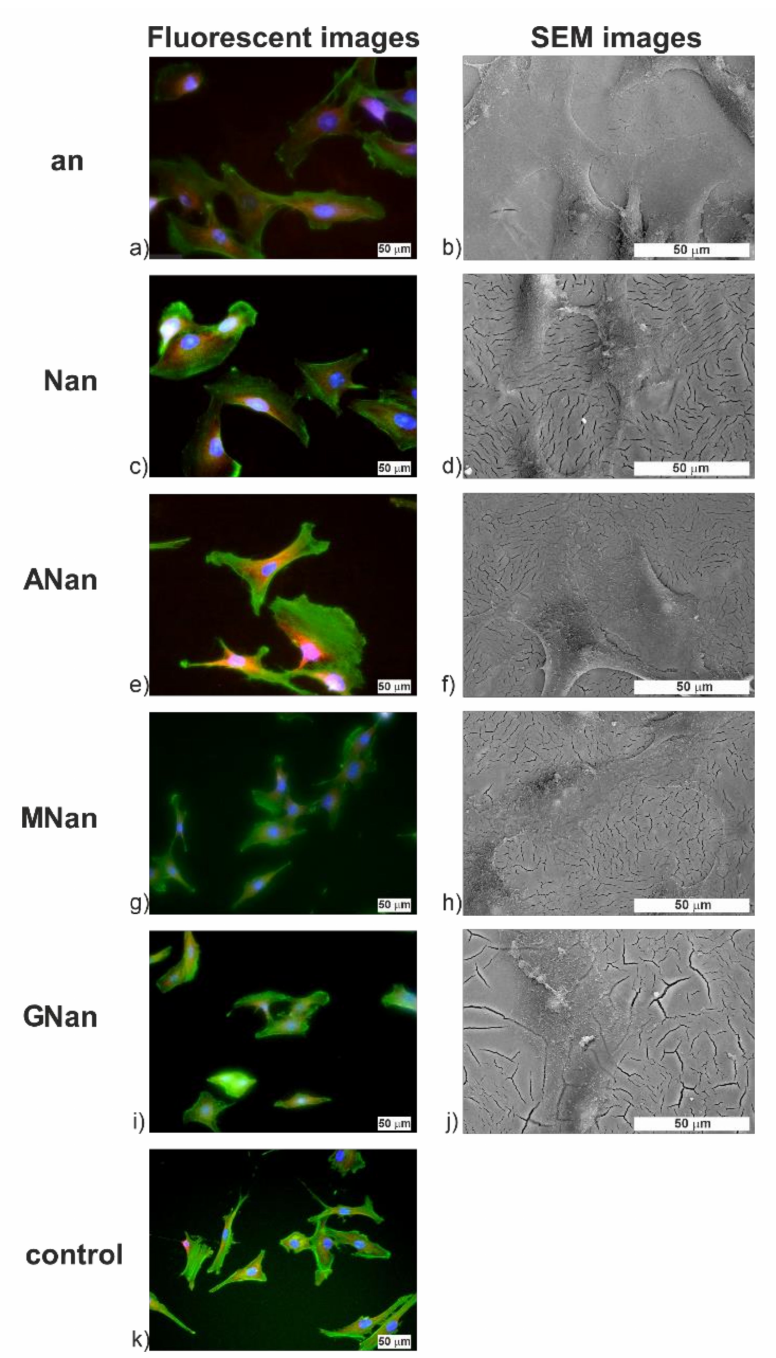
Figure 6. Representative immunofluorescence and FE-SEM microphotographs of MG-63 osteoblast- like cells grown on the non-modified (an) ( a , b ) and modified (Nan, Anan, GNan, and MNan) ( c – j ) TiO 2 samples, and the control (polystyrene) ( k ) after 24 h of culture. For fluorescent microscopy imaging, cells were stained with actin skeleton (green), cell nuclei (blue), and vinculin (red). Scale bar = 50 µ